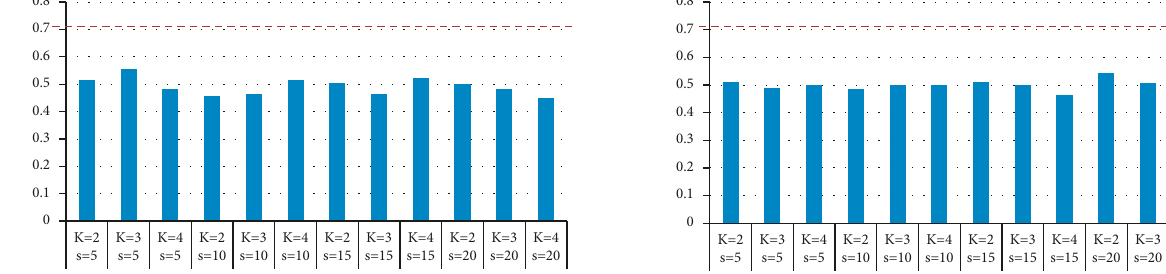
Figure 13: G -mean of CBCD on BAC with a threshold 0.005. Figure 10: G -mean of CBCD on BAC with a threshold